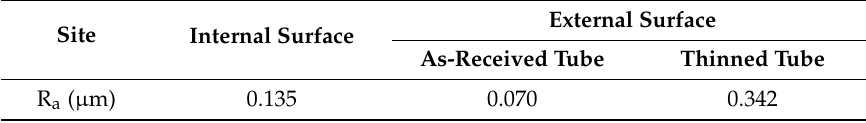
Table 3. The average surface roughness of as-received and thinned tube specimens.